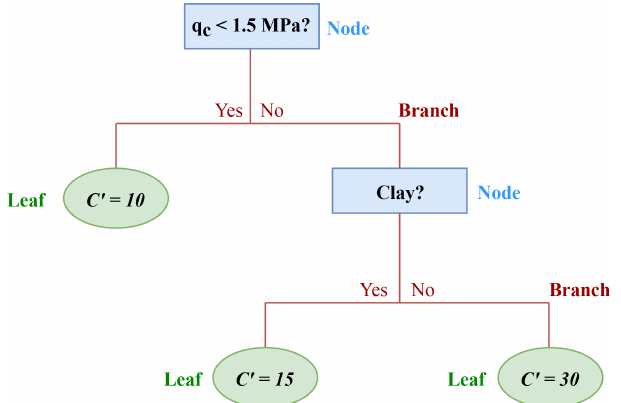
Figure 3. Example of a basic decision